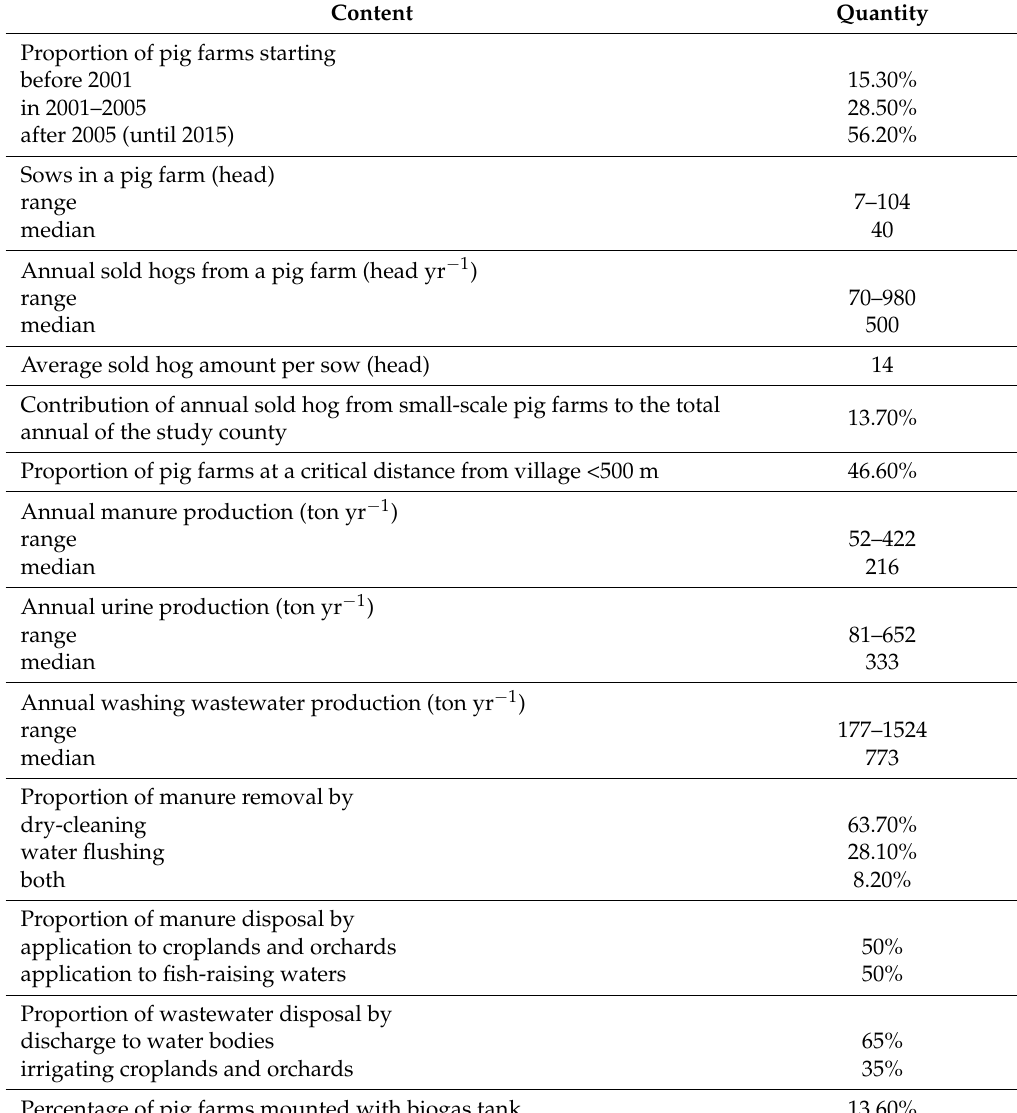
Table 1. Basic information on small-scale pig farming in the study area ( n =